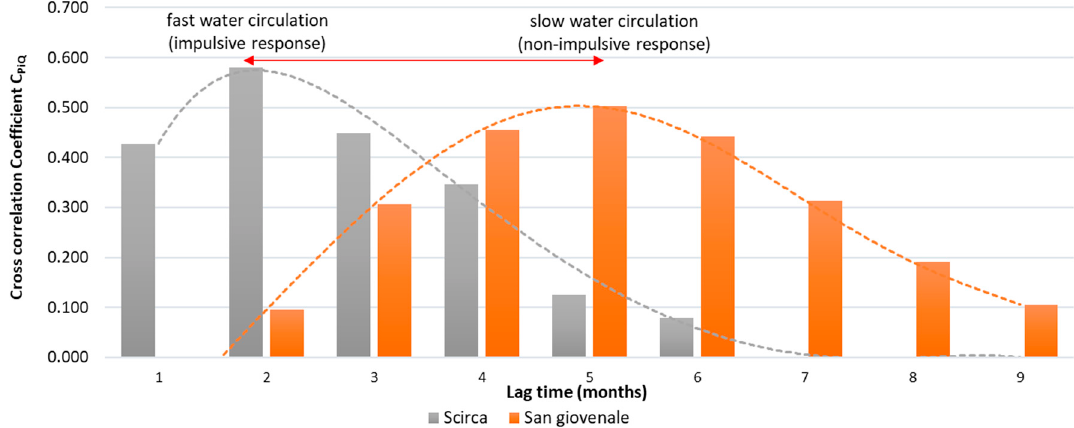
Figure 5. C PiQ values obtained for two test springs in Italy (Scirca Spring and San Giovenale Spring).